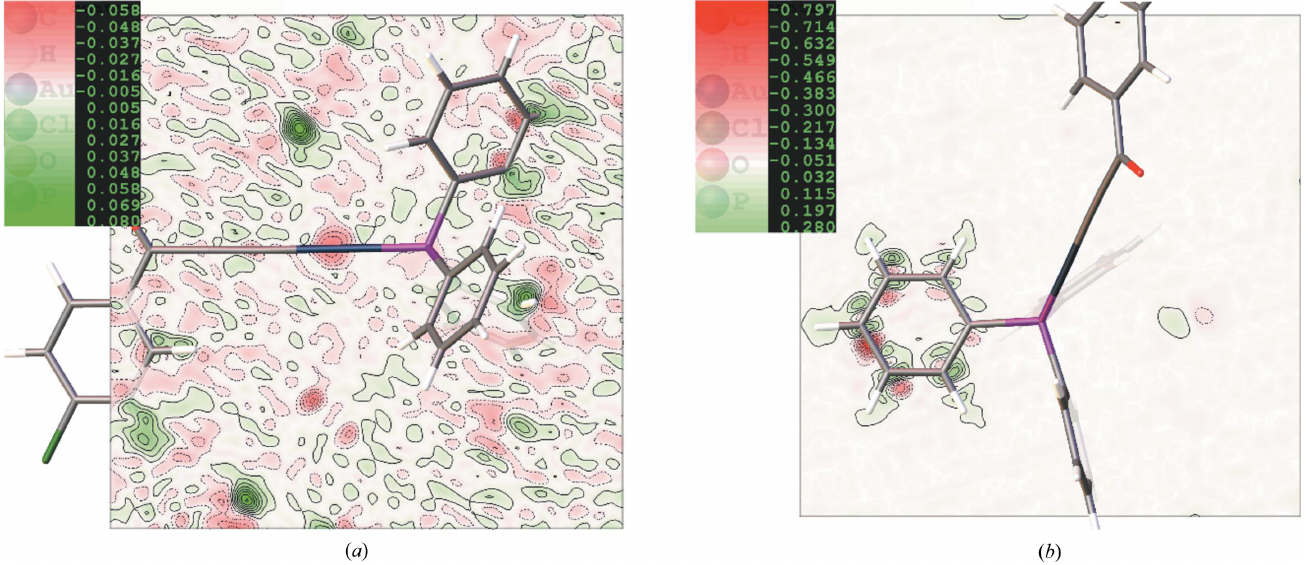
Figure 4 2D visualization of the dynamic electron density (eA˚ (cid:5) 3 ) calculated as the difference between rks_rel_anis_dis and rks_rel_anis_no_dis HAR models in the vicinity of ( a ) C–Au–P atoms and ( b ) the disordered phenyl ring. The dynamic electron density was calculated with Olex2 computed by inverse Fourier transformation of calculated structure factors.